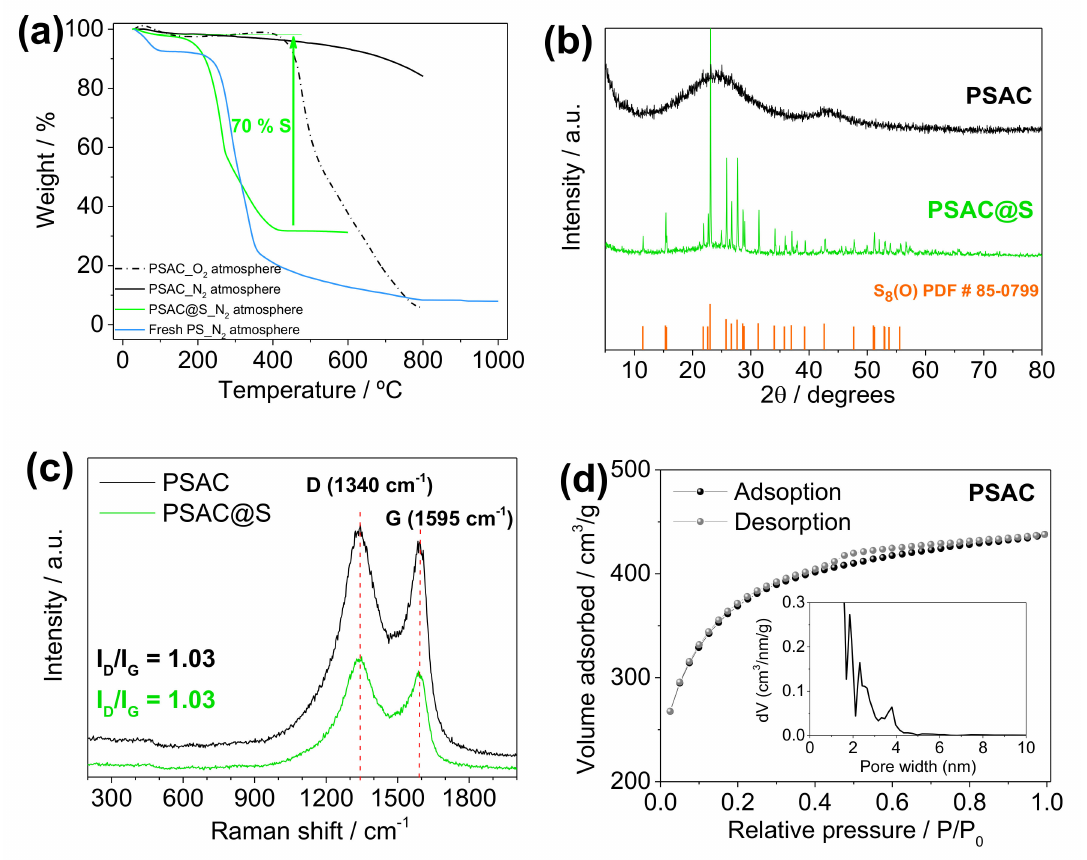
Figure 1. ( a ) Thermogravimetric analysis (TGA) curves of fresh pistachio shell (blue line) in a nitrogen atmosphere, pistachio shell-derived activated carbon (PSAC) in oxygen (dotted black line) and nitrogen (black line) atmospheres, and PSAC@S composite (green line) in a nitrogen atmosphere. ( b ) X-ray di ff raction (XRD) patterns and ( c ) Raman spectra of PSAC and the PSAC@S composite. ( d ) N 2 adsorption / desorption isotherm and pore size distribution of